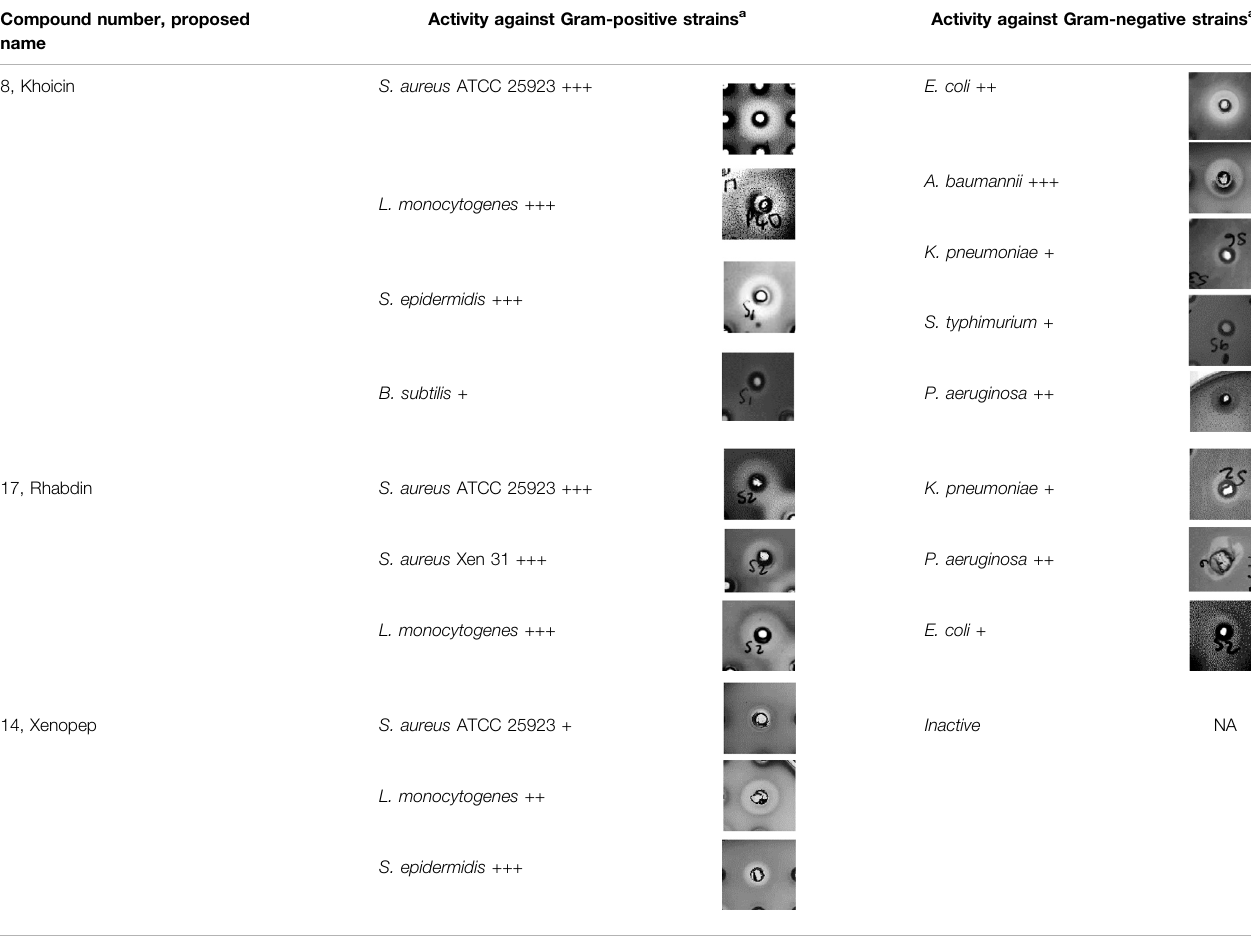
TABLE 4 | Comparison of the antimicrobial activity spectrum of puri fi ed and partially puri fi ed novel compounds identi fi ed in the four X. khoisanae J194 extracts. Compound number, proposed